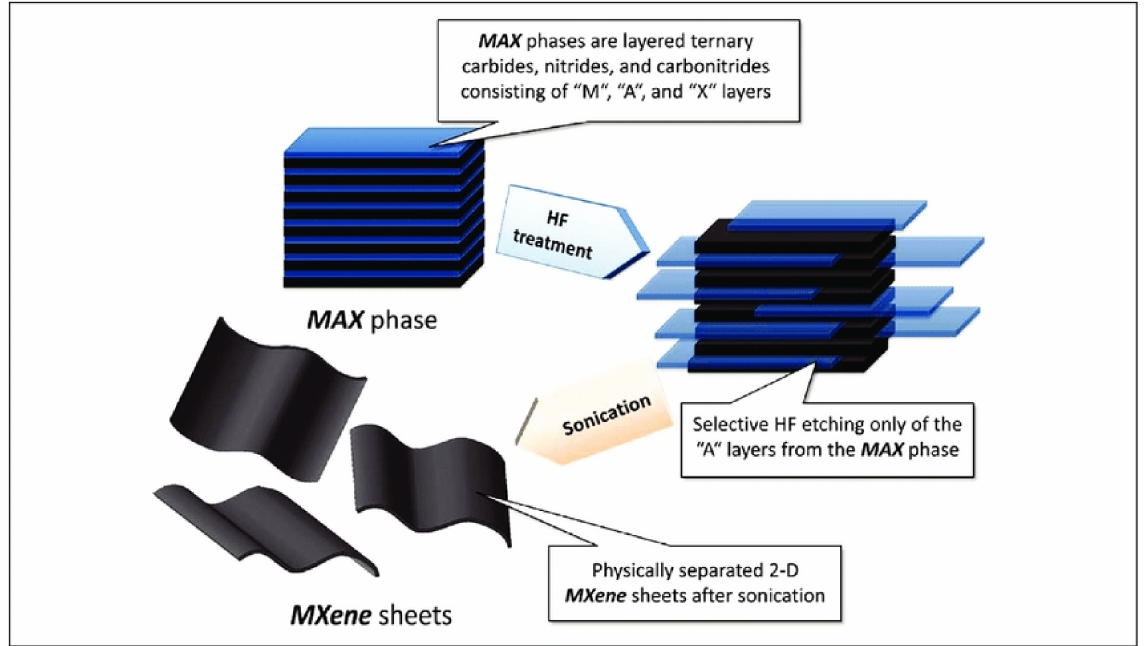
Figure 3. Schematic diagram of MXene formation. The blue-black layered structure (MAX phase) is treated with HF, which selectively removes the blue layers (A layer etching). The black multi-layered structure is then sonicated to yield 2D MXene sheets. Reprinted with permission from ref. [23] (Naguib, Mochalin, Barsoum, & Gogotsi, 2014). Copyright 2013 Wiley-VCH Veralg GmbH &Co.